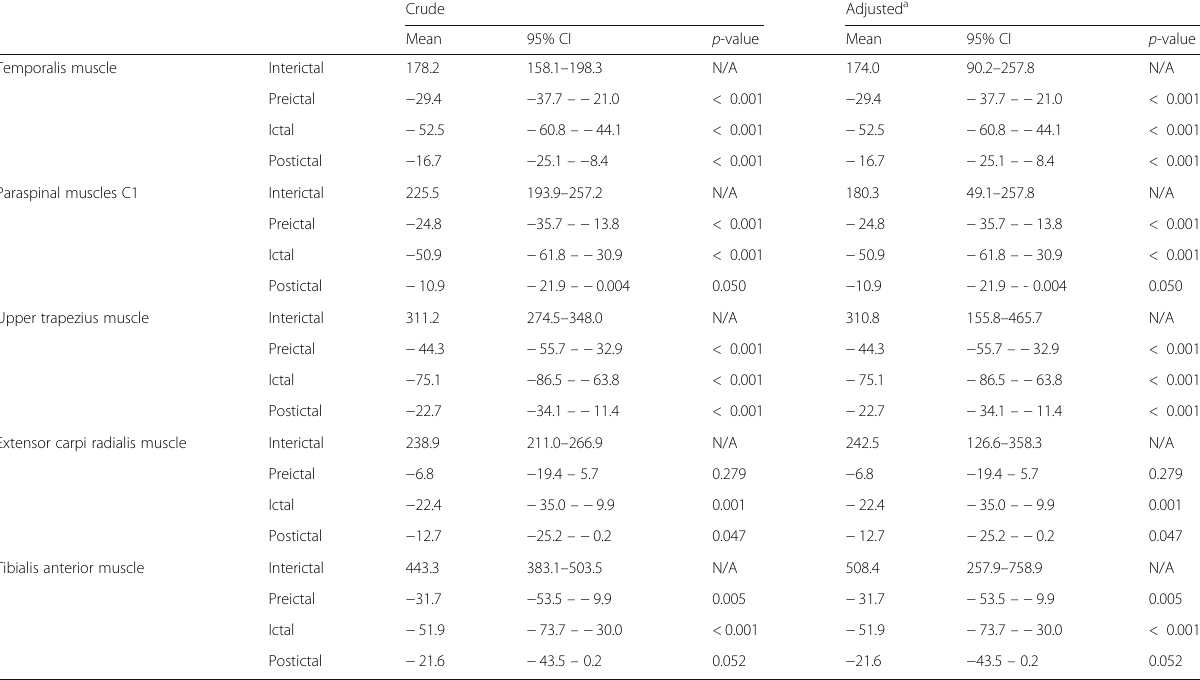
Table 4 Differences in pressure pain thresholds for the preictal, ictal and postictal phase compared to the interictal phase in people with migraine (non-dominant